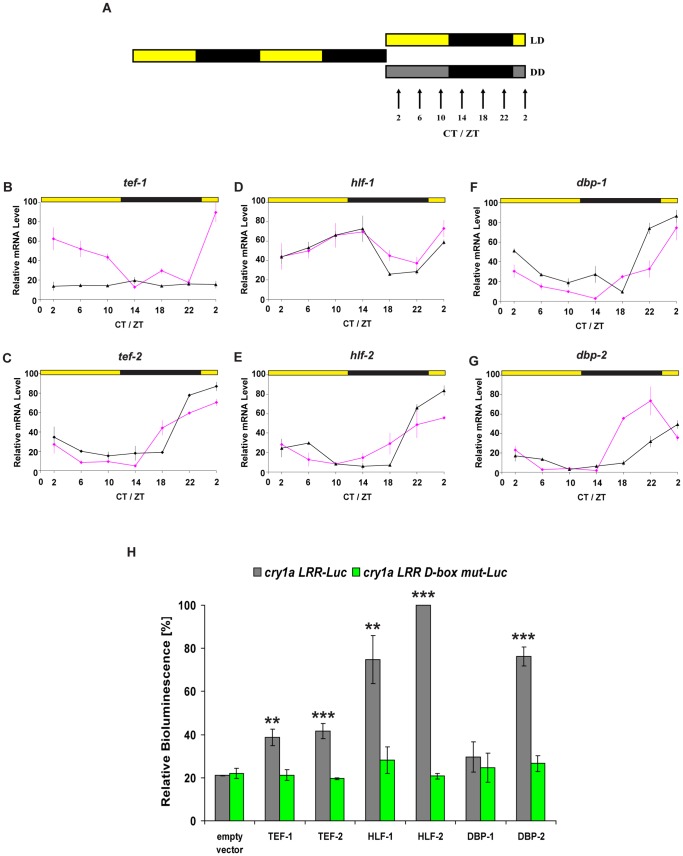
Regulation of the cry1a D-box by PAR bZip transcription factors.(A) Schematic representation of the experimental design. Black and yellow bars represents 12 hours dark and light periods respectively, while the dark grey bar denotes the subjective day period under constant darkness. Arrows indicate sampling time points where ZT and CT represent zeitgeber times and circadian times respectively (ZT0 represents “lights on”). (B–G) qRT-PCR analysis of PAR bZip gene expression in PAC-2 cells under LD (pink traces) and DD (black traces) conditions. Each gene is indicated above its respective panel. Relative mRNA levels are plotted on the y-axis and ZT or CT times on the x-axes. In each panel, points are plotted as the means of three independent experiments +/− SD. Yellow and black bars above each panel represent the light and dark periods, respectively. The statistical significance of rhythmic expression was assessed by t-test analysis in Table S2 C. (H) In vitro luciferase assay of PAC-2 cells co-transfected with expression constructs encoding the six PAR bZip factors and the cry1a LRR-Luc or cry1a LRR D-box mut-Luc reporters (dark grey and green bars, respectively). Each expression construct is indicated below its respective bars. Relative bioluminescence levels (%) are plotted on the y-axis where the highest value measured during the experiment is set arbitrarily as 100%. The results are plotted as the means of three independent experiments performed in triplicate, +/− SD. Each independent experiment was standardized for transfection efficiency using a β-galactosidase assay. The statistical significance of levels of transactivation was assessed by t-test analysis with * p<0.05, ** p<0.001, *** p<0.0001.